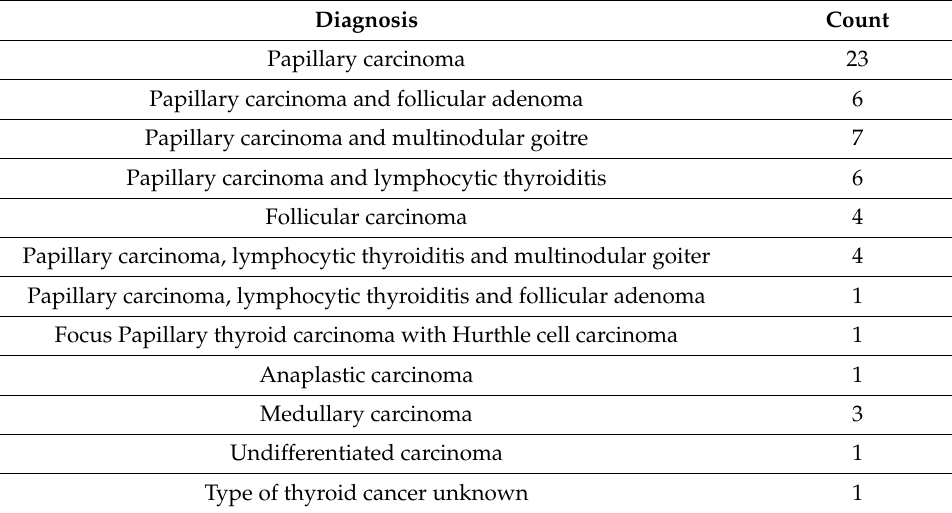
Table 2. Distribution of thyroid carcinoma subtypes diagnosed in 2008 and